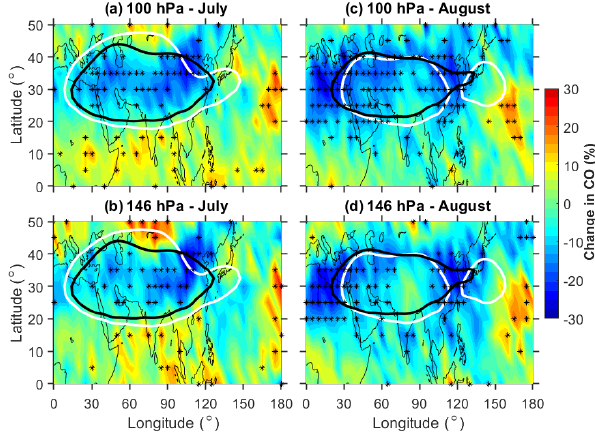
Figure 8. Carbon monoxide relative percentage change during July 2015 with respect to climatological monthly mean observed at (a) 100hPa and (b) 146hPa. Subplots of (c) and (d) same as (a) and (b) but for the month of August. The white (black) color con- tour represents the 16.75km geopotential height at 100hPa for the corresponding month in 2015 (mean of 2005–2014). The star sym- bols (black) shown in the figure represent the anomalies greater than the ± 2 σ standard deviation of the long-term mean. The results are obtained from MLS measurements.